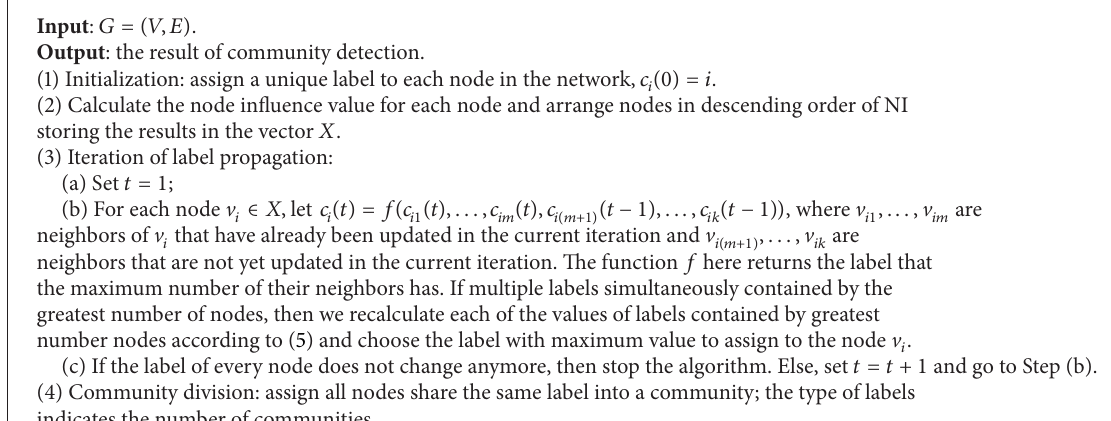
Algorithm 2: Node influence based label propagation algorithm for community detection in networks (NIBLPA).